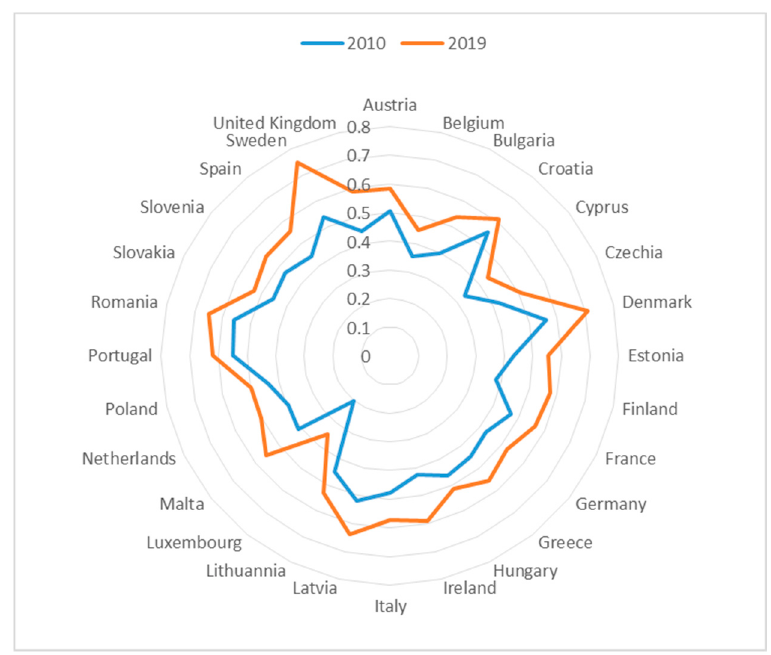
Figure 2. The average level of the set fulfilment climate/energy targets of Euro 2020 strategy in case of the EU28 in the years 2010 and 2019.